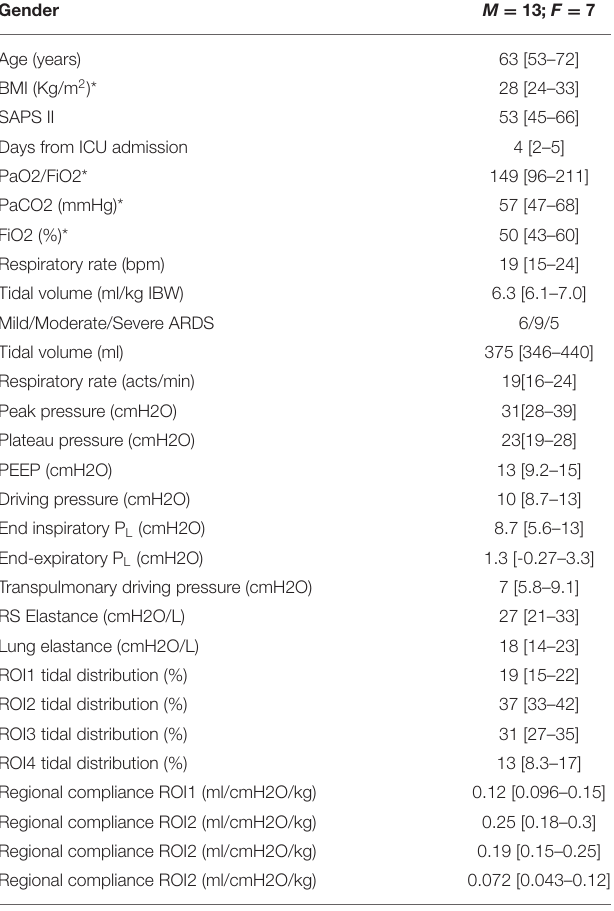
TABLE 1 | Main characteristics of the patients and the pooled measurements. TABLE 2 | Repeated measures correlation (rmcorr) analysis between electrical